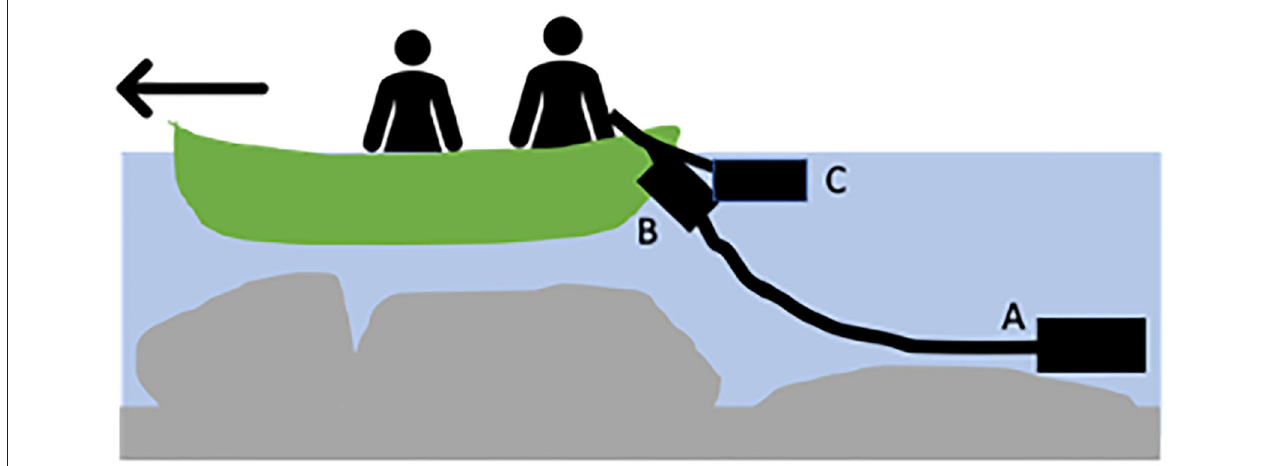
FIGURE 3 | Data collection schematic; (A) temperature and EC sensors were deployed on a “long rope” to collect data near the riverbed, (B) temperature and EC sensors were also deployed in shallow water, and (C) during August 2018, the SUNA sensor was deployed near the shallow sensors.